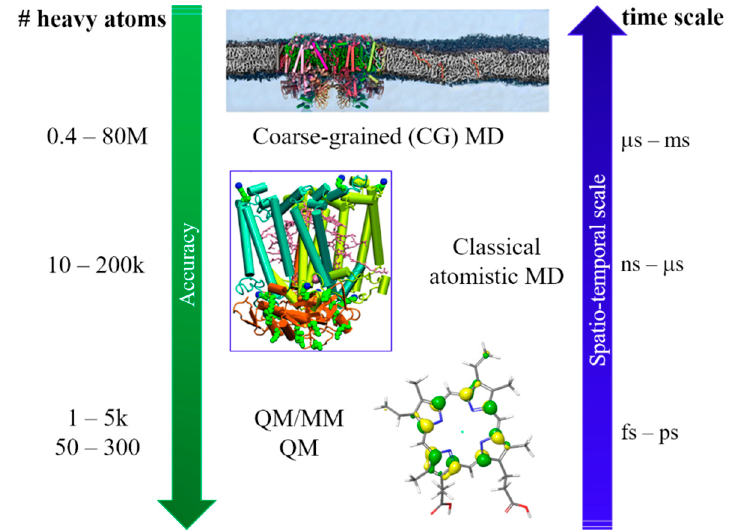
Figure 1. Multiscale approach for the study of photosynthetic interfaces. Different spatio-temporal resolution are reported. While the system size increases, longer simulation times are required, at the expenses of a decrease in accuracy. Adapted from [14], Springer, 2020. Abbreviations: Quantum mechanics (QM), QM/molecular mechanics (MM), and molecular dynamic (MD).